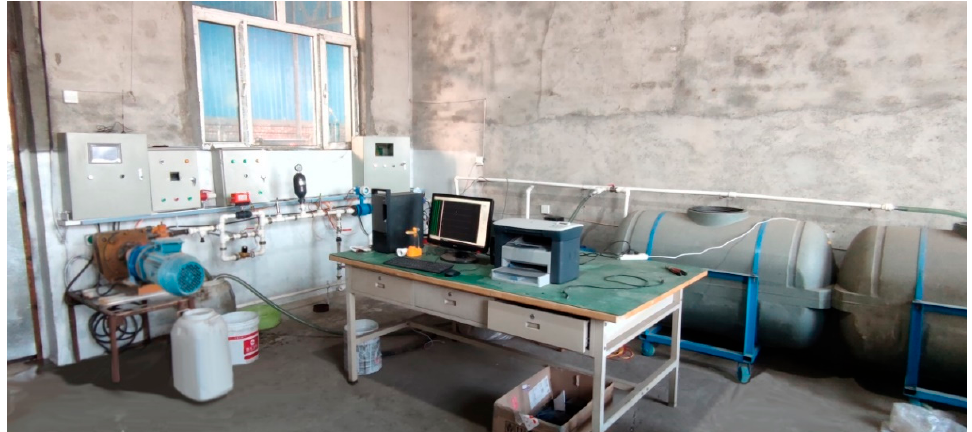
Figure 15. pH regulation experimental platform.